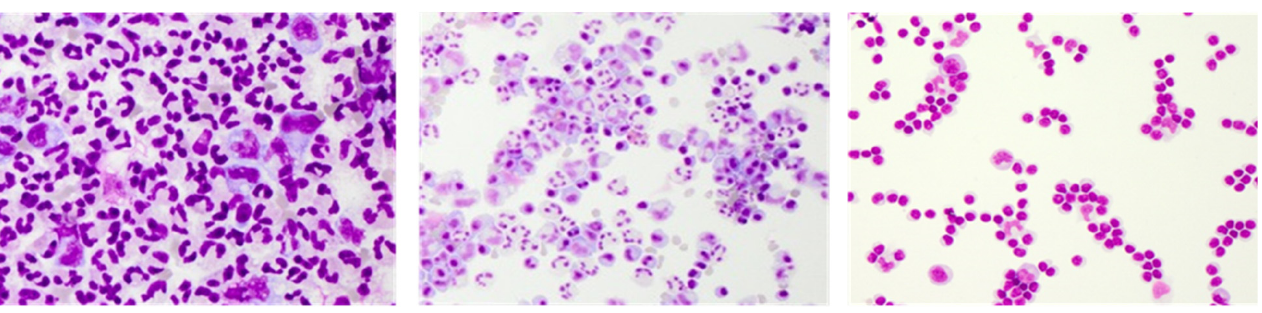
Figure 3. Representative May–Grünwald stained CSF cytology images of bacterial meningitis ( left ), viral meningitis ( middle ), and an autoimmune central nervous system (CNS) disease ( right ). Cytol-